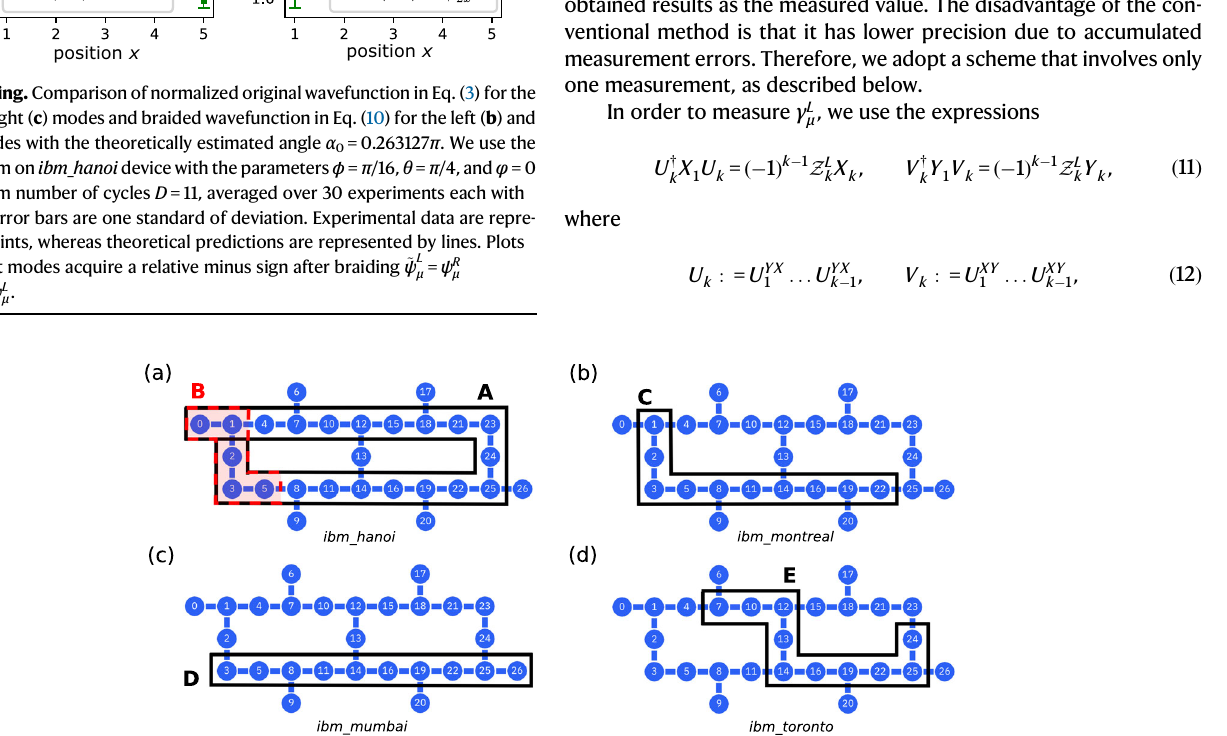
Fig. 4 | Con fi guration of IBM hardware. a Layout of the ibm_hanoi device. Sequence A of 21 qubits was used to generate the frequency-resolved boundary oscillations shown in Fig. 1 c ; sequence B of 10 qubits was used to perform the braiding experiment shown in Fig. 3. b Layout for the ibm_montreal device. SequenceCof10qubitswasusedtoreproducetheMajoranamodetomographyin